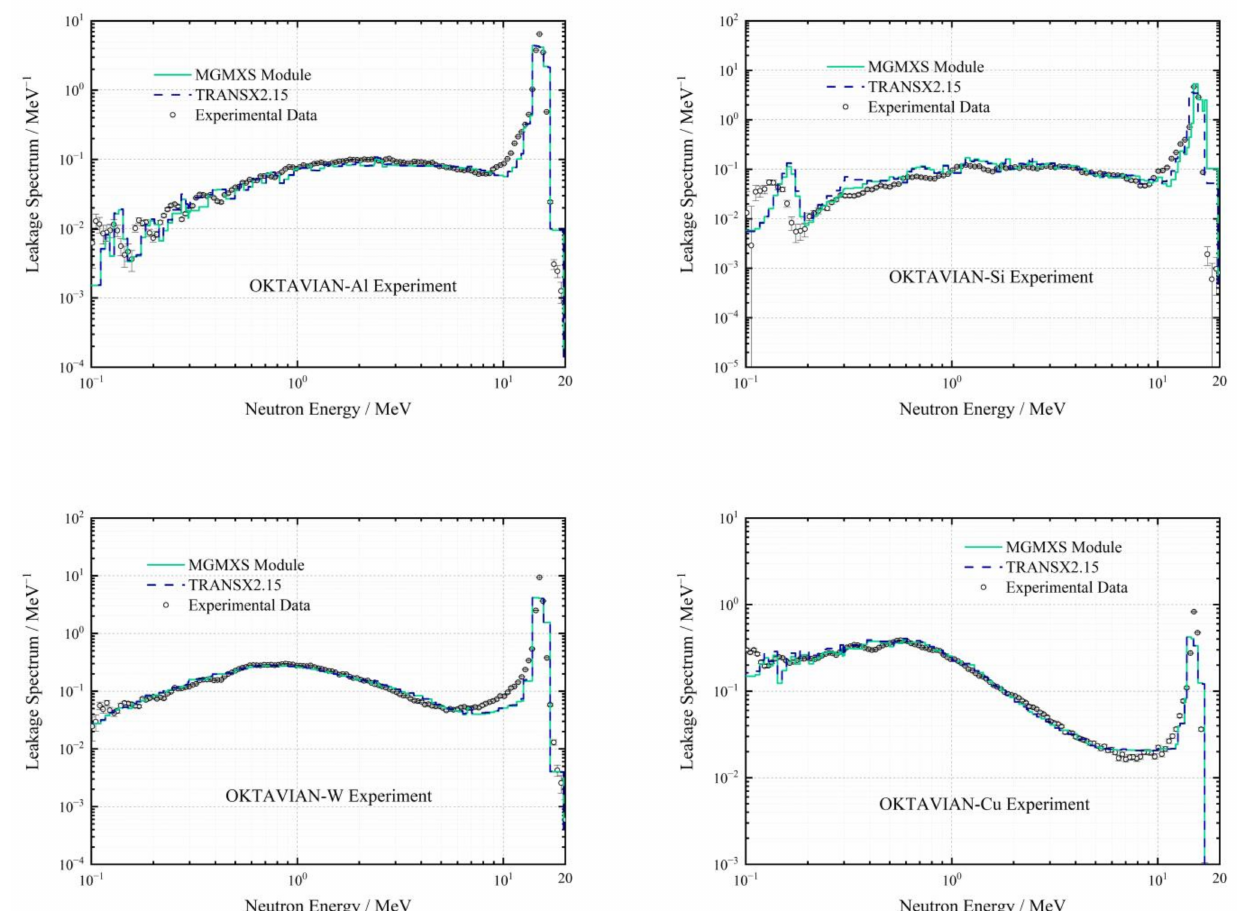
Figure 11. Comparison of experimental and calculated results of neutron leakage